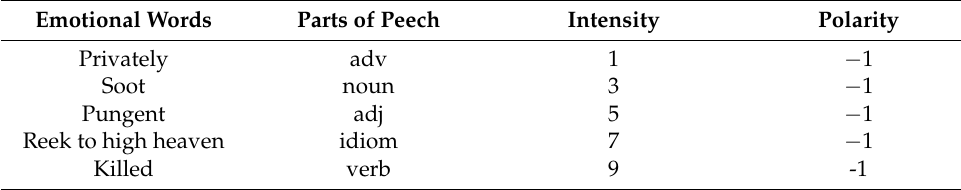
Table 3. The examples of the air pollution emotion